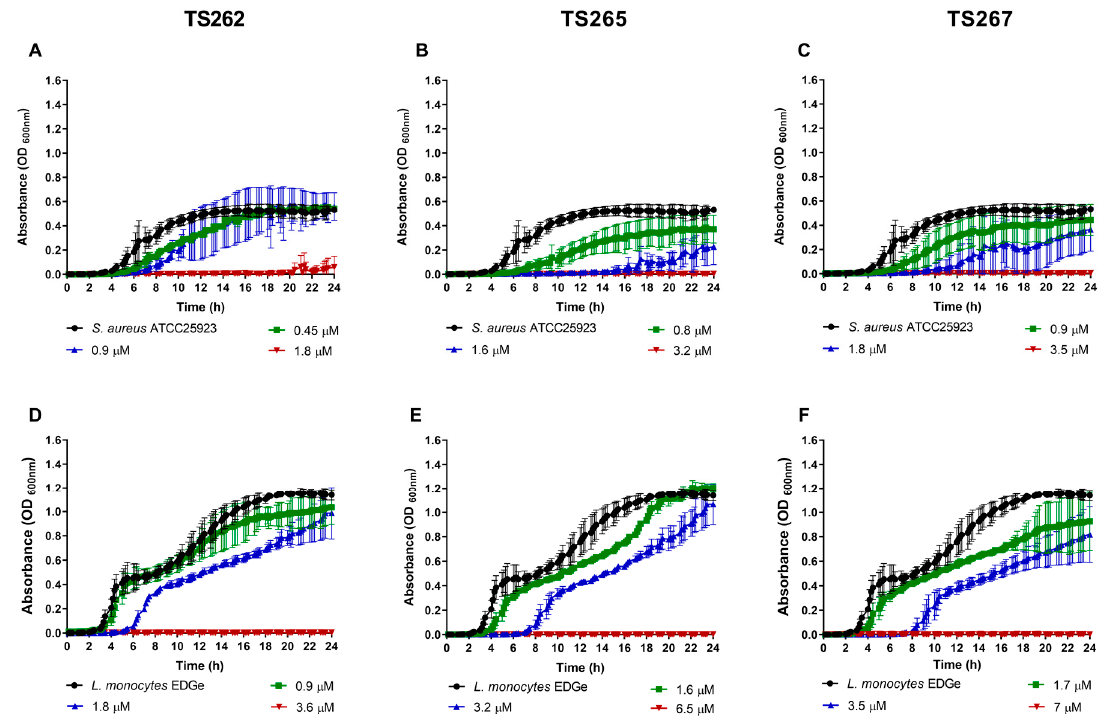
Figure 1. Growth kinetics of Gram-positive bacteria in the presence of the three metallic compounds. E ff ect of the metallic compounds on the growth of S. aureus ATCC25923 ( A – C ) and Listeria monocytogenes EDGe ( D – F ) in Mueller–Hinton (MH) broth. The results correspond to the average of three independent experiments ± standard deviation (SD). Table 2. Summary of the e ff ect of the three metallic compounds on the bacterial lag phase. Lag Phases (in Bacterial Strains